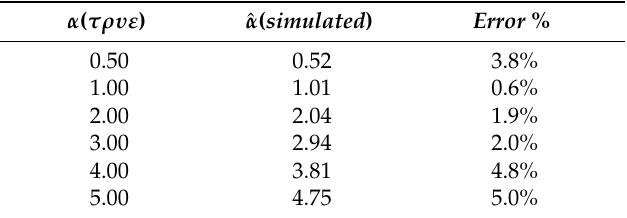
Table 2. Simulation results with κ = 0.00003, J = 1.5 J th .